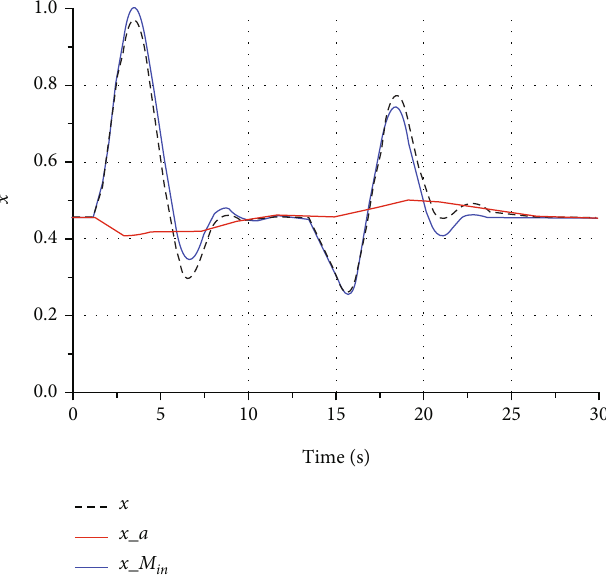
Figure 23: Relative opening of the out fl ow valve in fl uenced by di ff erent ambient environmental factors.